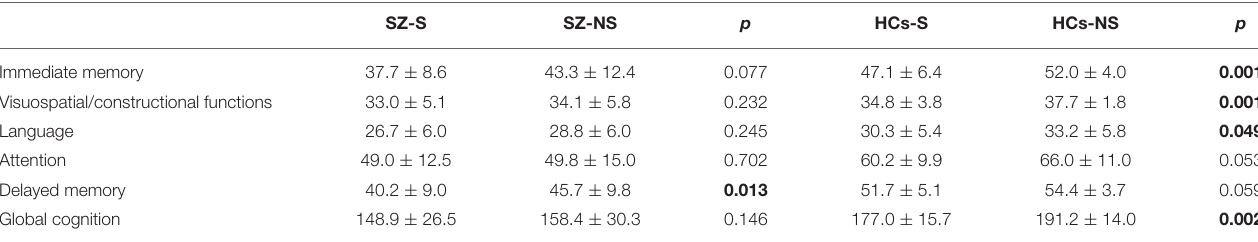
TABLE 3 | Cognitive performance with respect to cigarette smoking in patients with schizophrenia and healthy